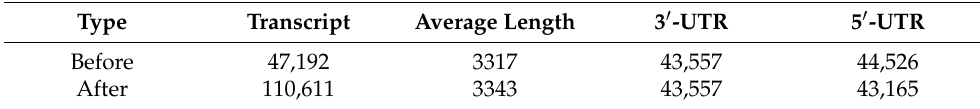
Figure 7. Prediction of the coding sequences and SSR types. ( A ) The length of 3 ′ UTR. ( B ) The length of 5 (cid:48) UTR. ( C ) Length distribution of CDSs. ( D ) Distribution map of SSR types. Table 3. Gene structure analysis before and after